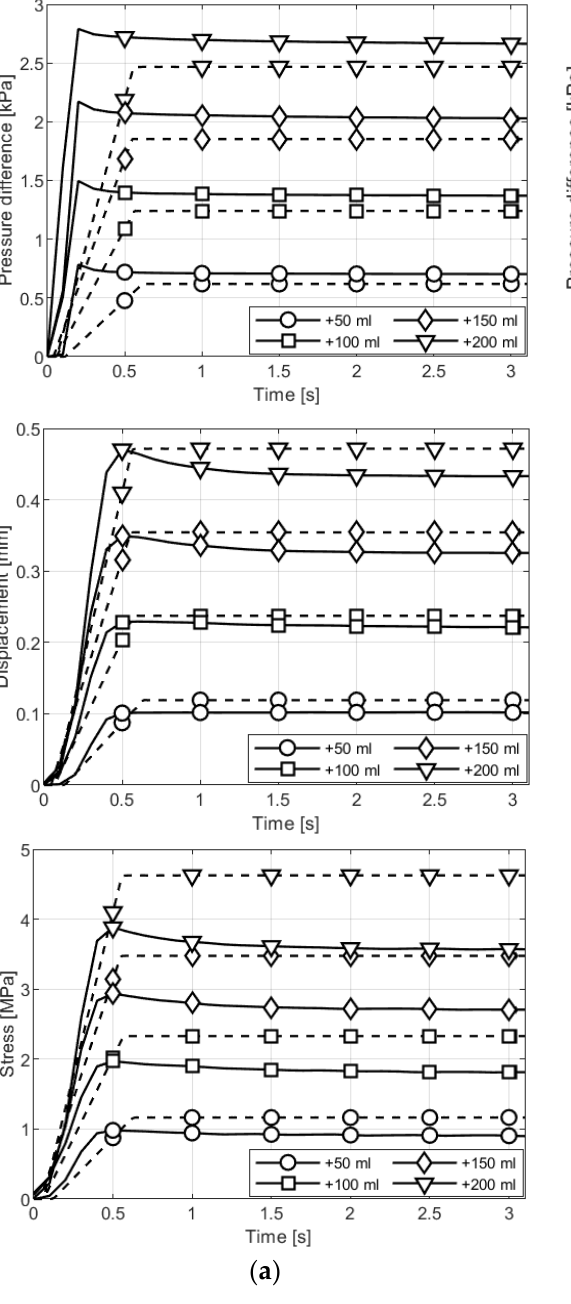
Figure 7. Comparison of the results of the experimental and numerical tests in terms of pressure difference, deflection of panes and stress in glass for: ( a ) injecting gas into the gap, ( b ) withdrawing gas from the gap. Note: a solid line represents the results of laboratory tests, while the results of numerical simulations are marked with a dashed line.